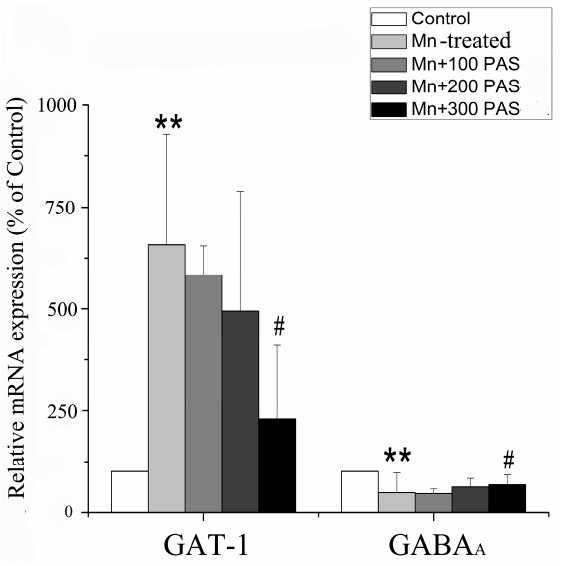
Figure 5. PAS-Na attenuated the changes of GABA A and GAT-1 in the transcription level in the basal ganglia of Mn-exposed rats. Data represent mean ± SD. N = 5 per group. ** p < 0.01: significant as compared to Control; # p < 0.05: significant as compared to Mn-treated group.